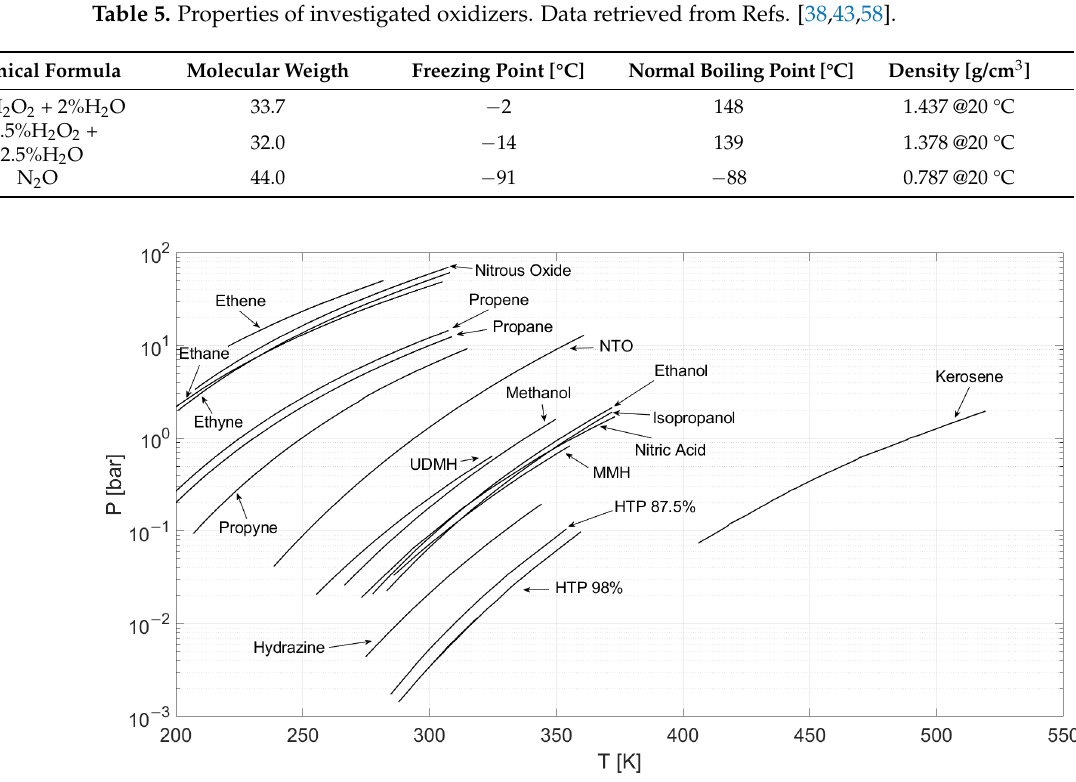
Figure 1. Oxidizers and fuels vapor pressure